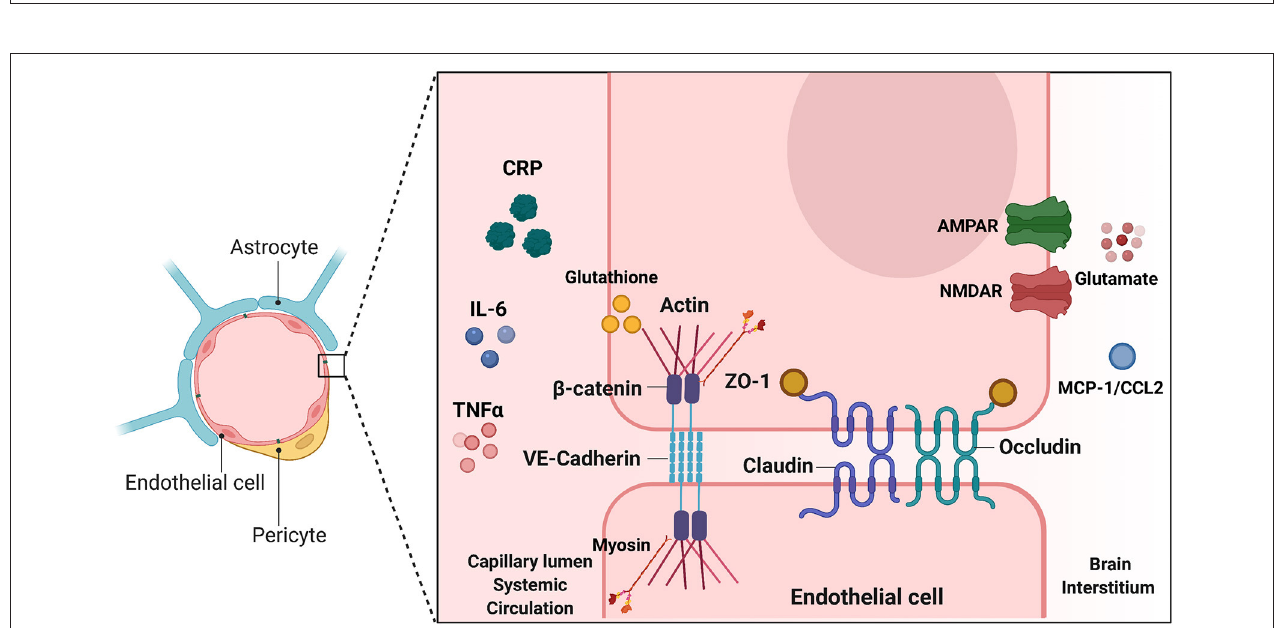
FIGURE 4 | Endothelial junctions at the Blood Brain Barrier. Illustration depicting tight junctions and adherens junctions in brain microvascular endothelial cells of the BBB. Inducers of BBB breakdown are shown both in the systemic circulation and brain interstitium. TJ and AJ proteins are depicted between the two endothelial cells. Inducers shown on either side of the BBB make modifications such as phosphorylation, or glutathionylation, that have downstream effects on TJ/AJ localization and expression. This alters BBB integrity and barrier leakiness. This image was created with Biorender.com.